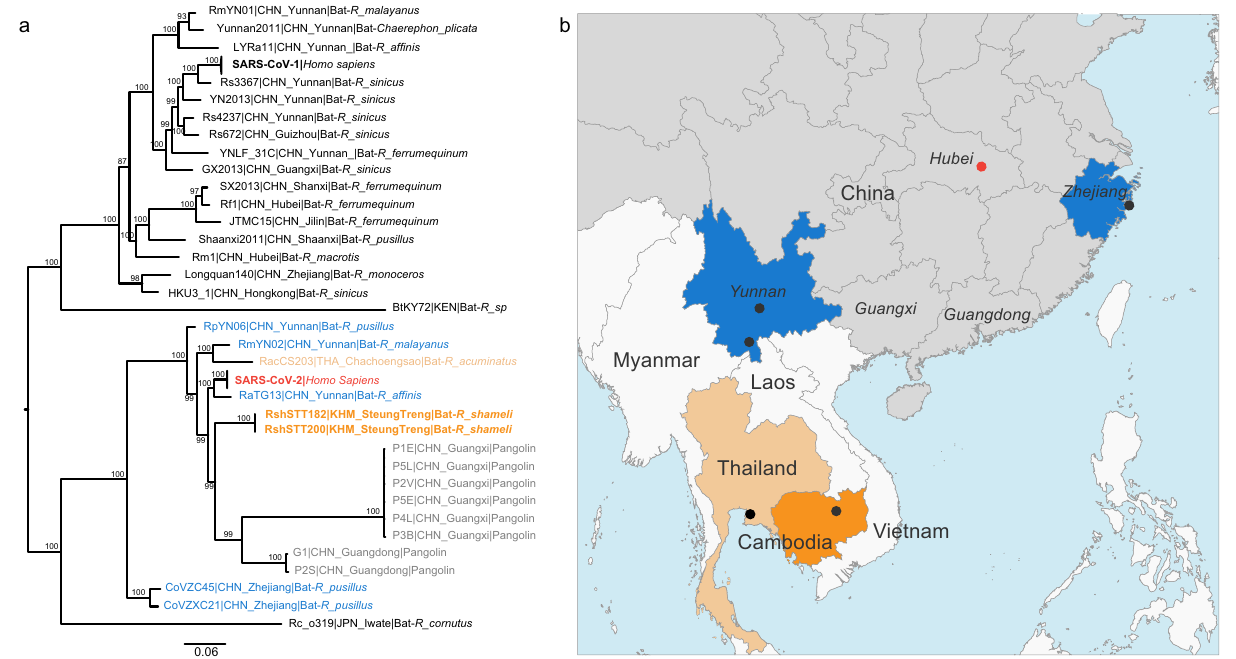
Fig. 1 Phylogenetic analysis of SARS-CoV-2 and representative sarbecoviruses and geographical context. a Maximum likelihood phylogeny of the subgenus Sarbecovirus (genus Betacoronavirus ; n = 39) estimated from complete genome sequences using IQ-TREE and 1000 replicates. The coronaviruses of the SARS-CoV-2 lineage are color coded by country of sampling as on the map. In orange, Cambodia, light orange, Thailand and blue, China. Taxa names include the isolate name, country and province of sampling, and host. The scienti fi c names of the hosts are abbreviated as follows: Bats: R. af fi nis, Rhinolophus af fi nis; R. sinicus, Rhinolophus sinicus; R. ferrumequinum, Rhinolophus ferrumequinum; R. malayanus, Rhinolophus malayanus; R. acuminatus, Rhinolophus acuminatus; C. plicata, Chaerephon plicata; R. pusillus, Rhinolophus pusillus; R. macrotis, Rhinolophus macrotis; R. monoceros, Rhinolophus monoceros; R. cornutus, Rhinolophus cornutus; Pangolin : M_javanica, Manis javanica and human: H. sapiens , Homo sapiens . A maximum clade credibility tree is available in Supplementary Fig. 3. b map of parts of China and Southeast Asia. Regions where viruses of the SARS-CoV-2 lineage were sampled are colored as in the tree. A black dot indicates a sampling site when known, and the red dot shows the location of Wuhan, where the fi rst cases of SARS-CoV-2 infection were